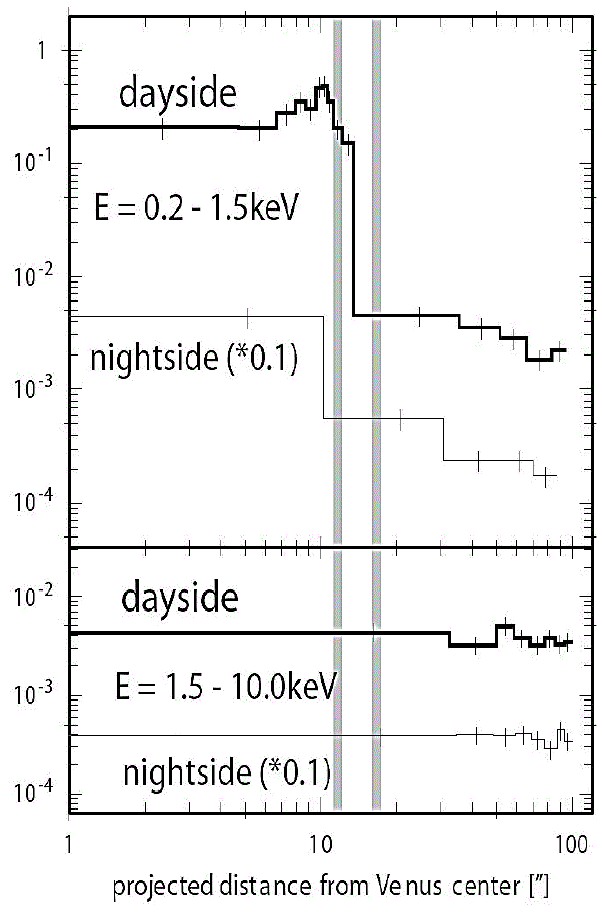
Fig. 2. Spatial distribution of photons in units of counts arcmin − 2 s − 1 around Venus in the ACIS-I observations (Dennerl et al., 2002). Two energy ranges are